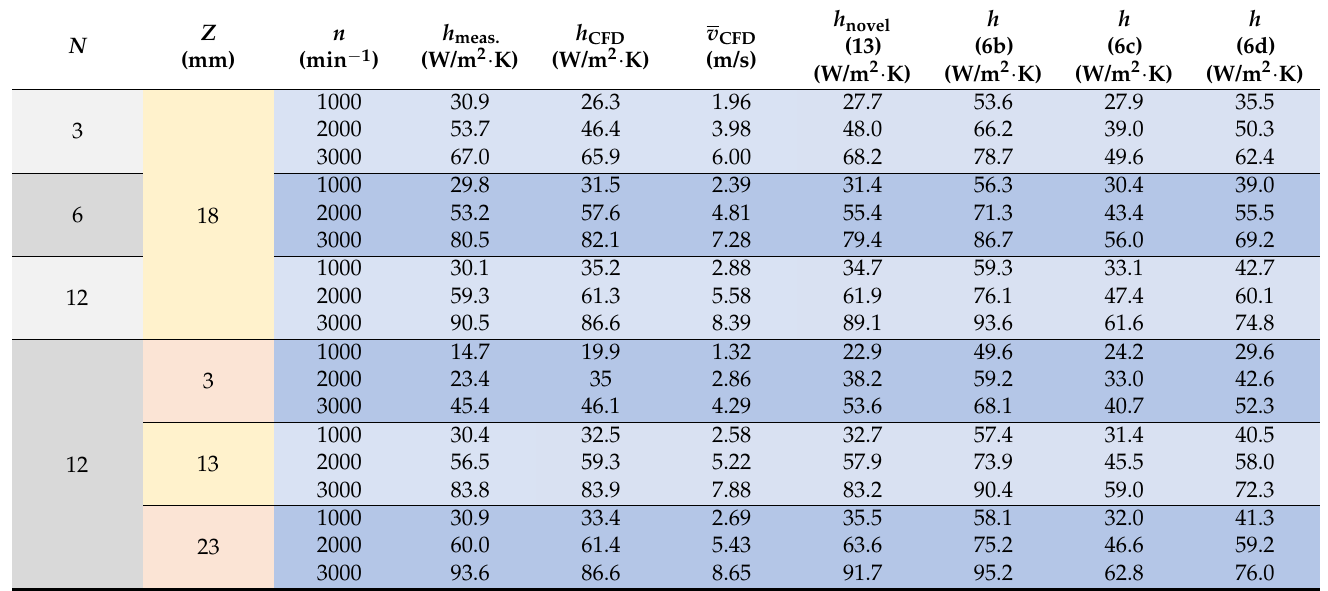
Table 7. Comparison between novel approach and reference equations for calculating HTC compared to measurements and CFD simulation results ( R = 52 mm).